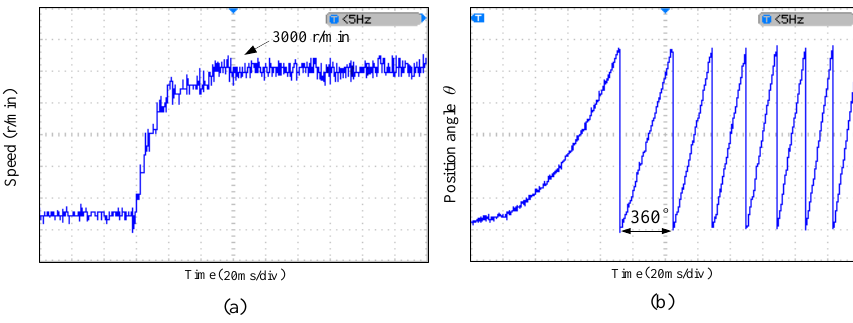
Figure 15. The experimental results of the control system. ( a ) The measured waveforms of rotational speed; ( b ) The waveform of the rotor position angle of SBPMSM stable operation to 3000 r/min.